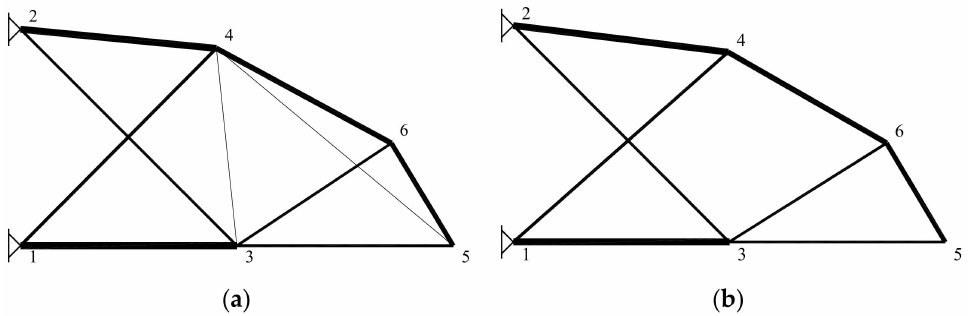
Figure 10. Optimal solutions, example TC10b (topology and shape optimization, without buckling constraints). ( a ) Initial topology; ( b ) optimal